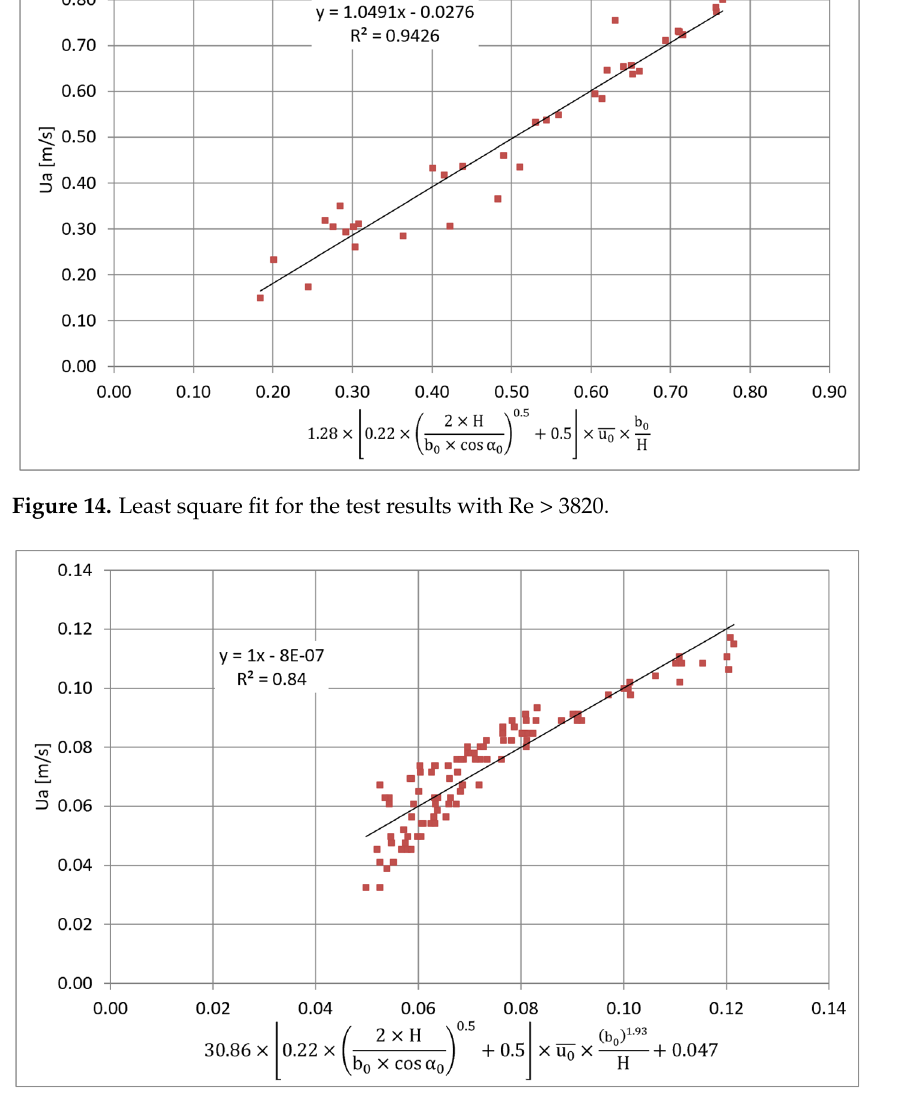
Figure 15. Least square fit for the test results with Re < 3820.